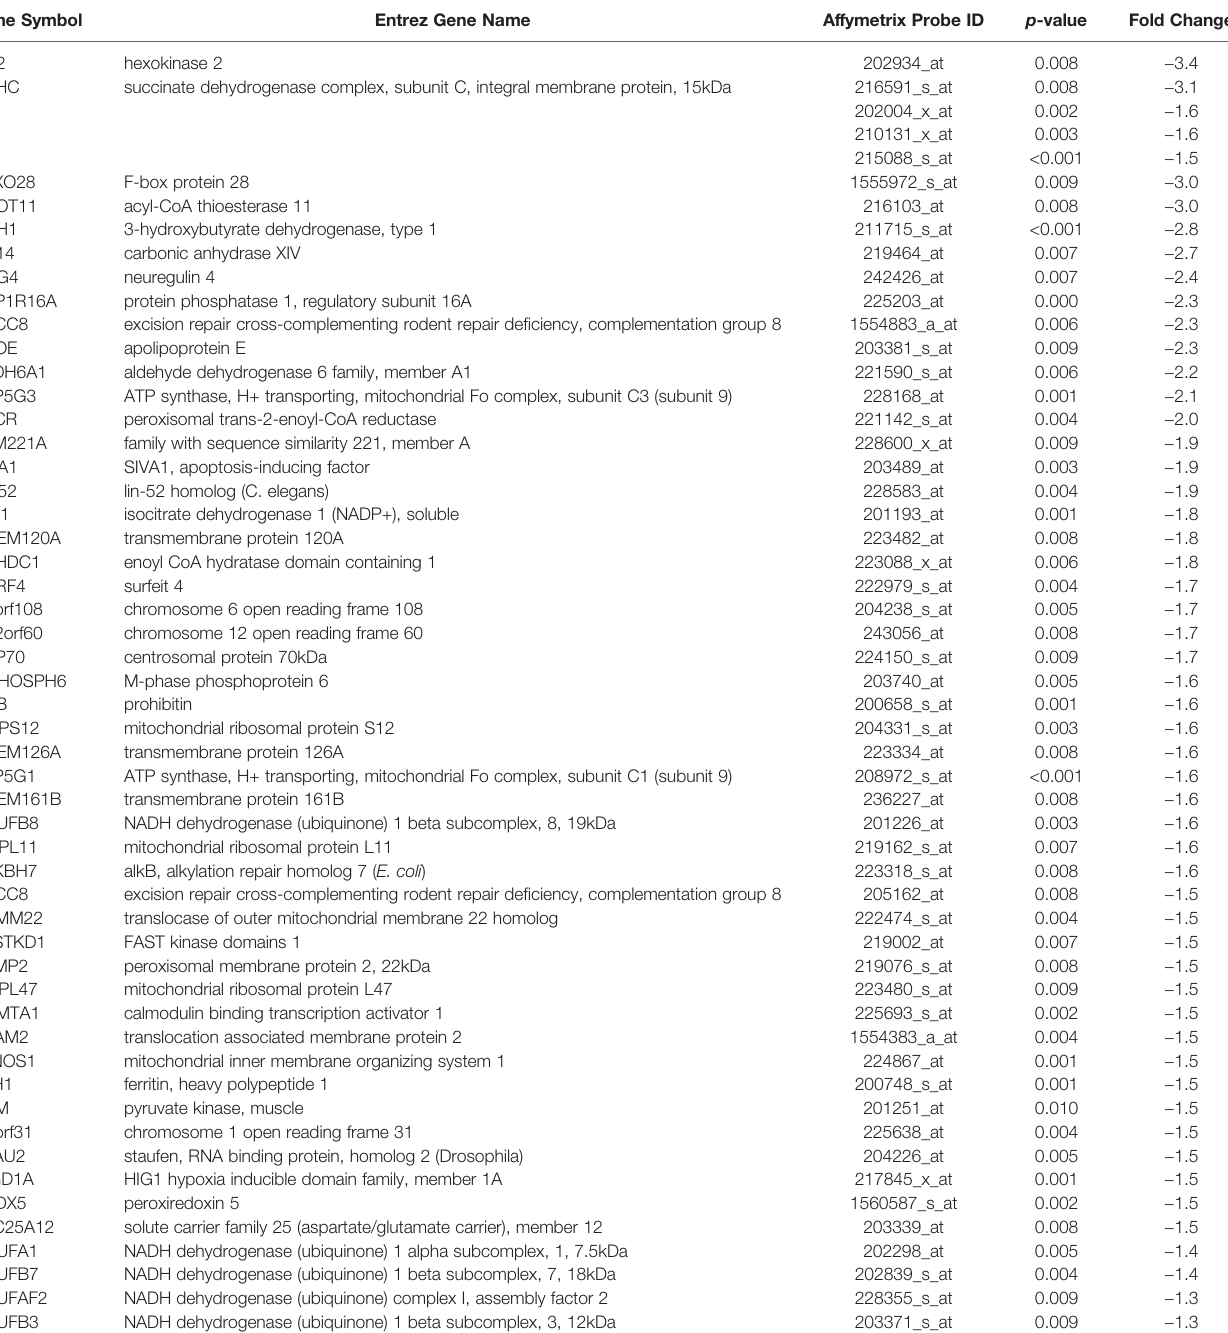
TABLE 2 | Baseline (Pre-RYGB) group differences in skeletal muscle gene expression for oxidative pathways.